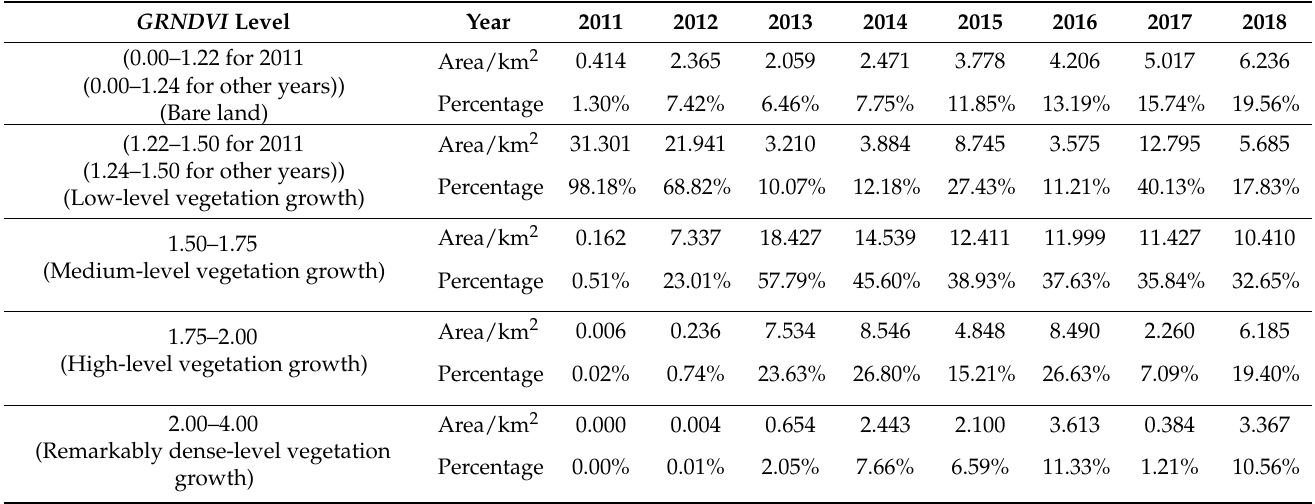
Table A1. The areas and percentages of different GRNDVI levels from 2011 to 2018 in the study region (1.22 is the threshold for 2011, and 1.24 is the threshold for other